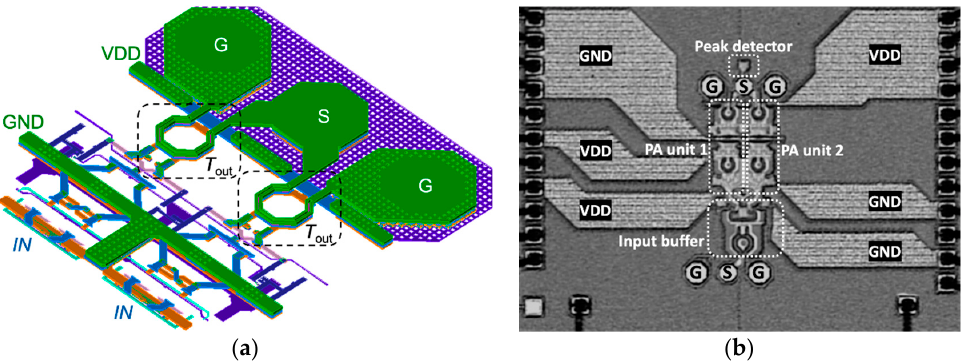
Figure 5. ( a ) 3D view of the passive circuitry of the power stages. ( b ) Die photograph of the 77 GHz PA.